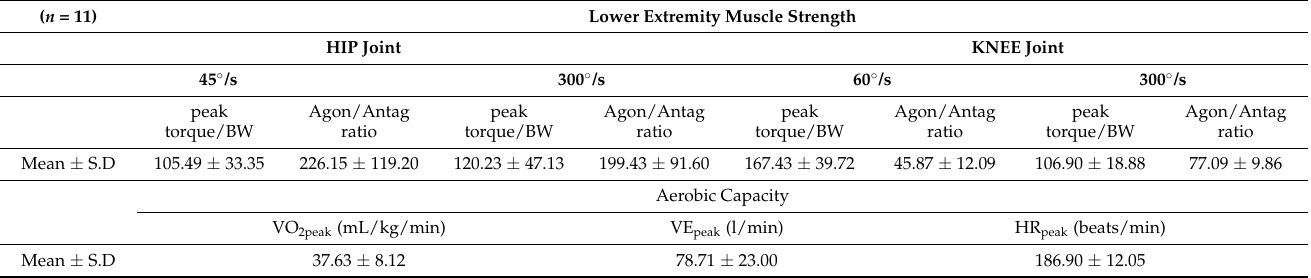
Table 1. Comparison of the Lower Extremity Muscle Strength and Aerobic Capacity (mean ± SD).